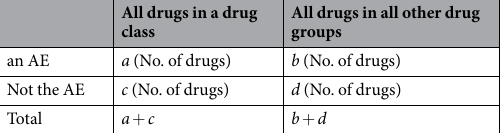
Table 1. A two-by-two contingency table for C-PRR calculation.